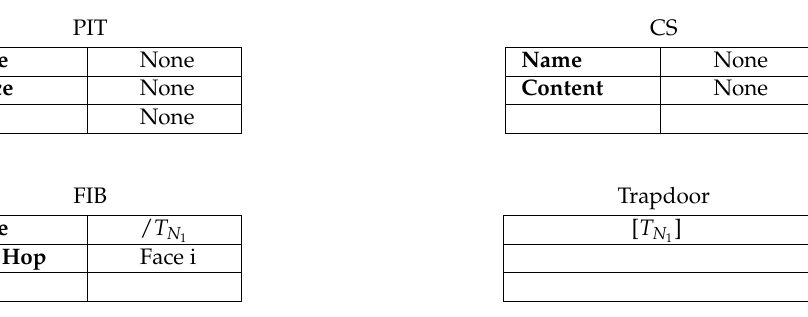
Figure 8. Router’s state after producer’s first dissemination.